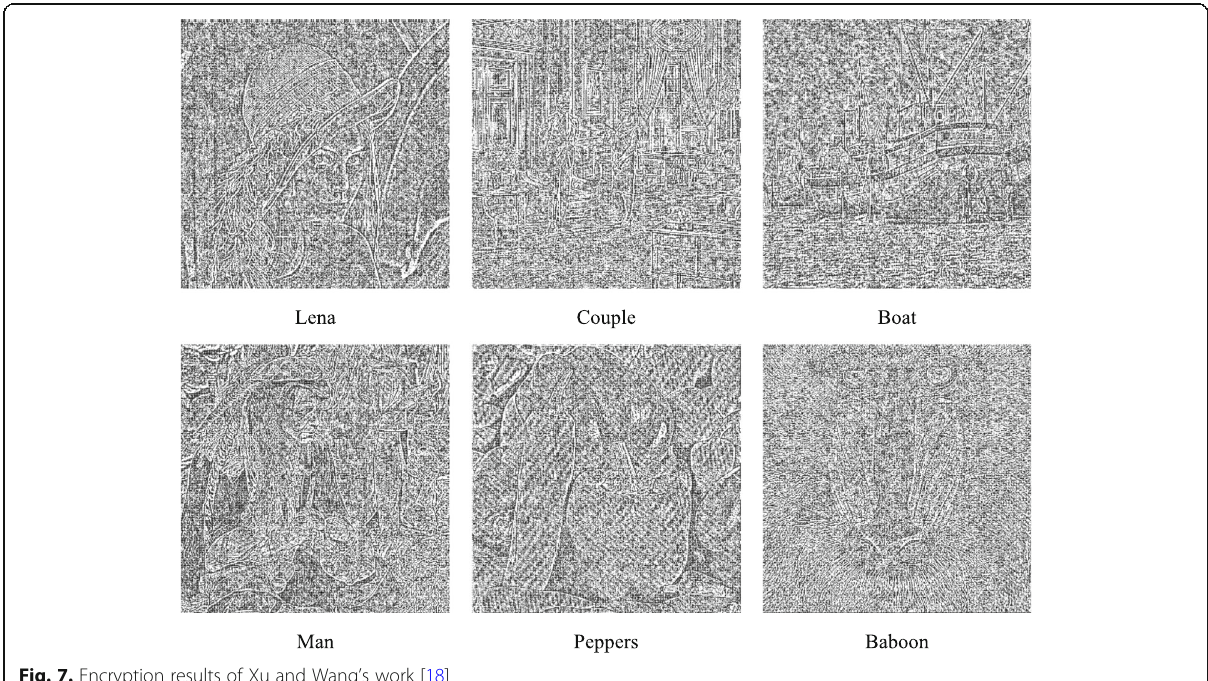
Fig. 7. Encryption results of Xu and Wang ’ s work [18]